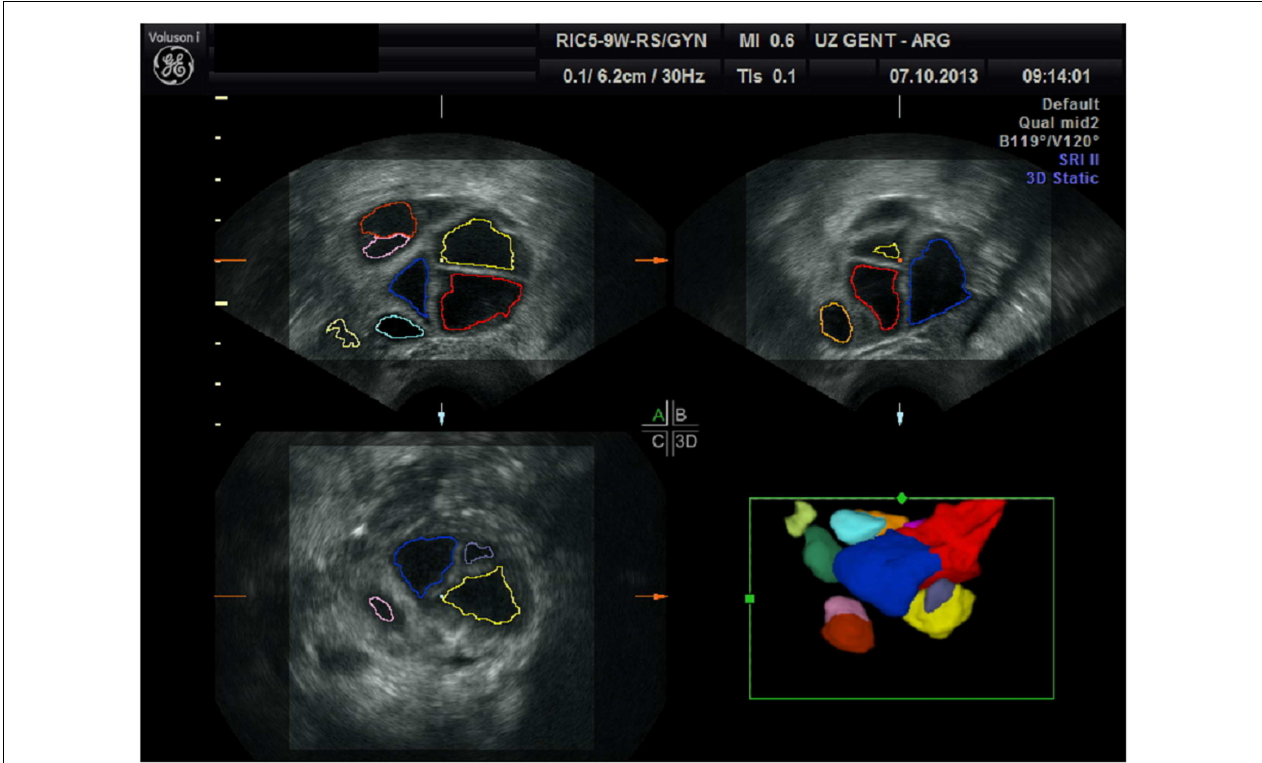
FIGURE 1 | Follicular measurement using sonography-based automated volume count (SonoAVC)